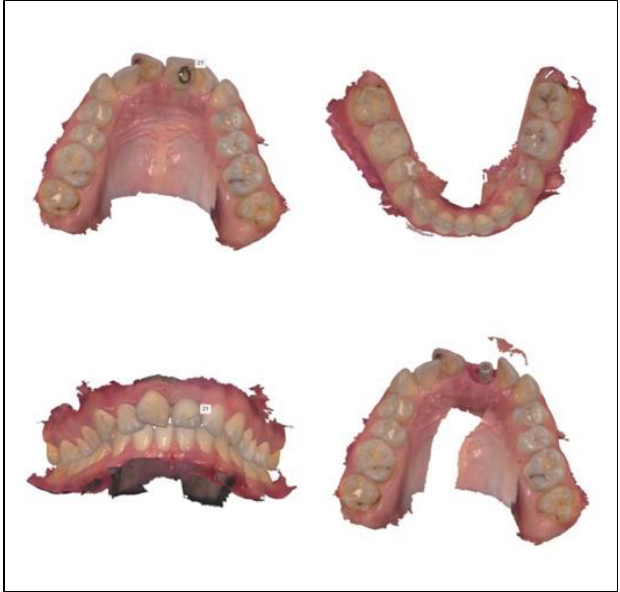
Figure 9. Scan with the scan body.